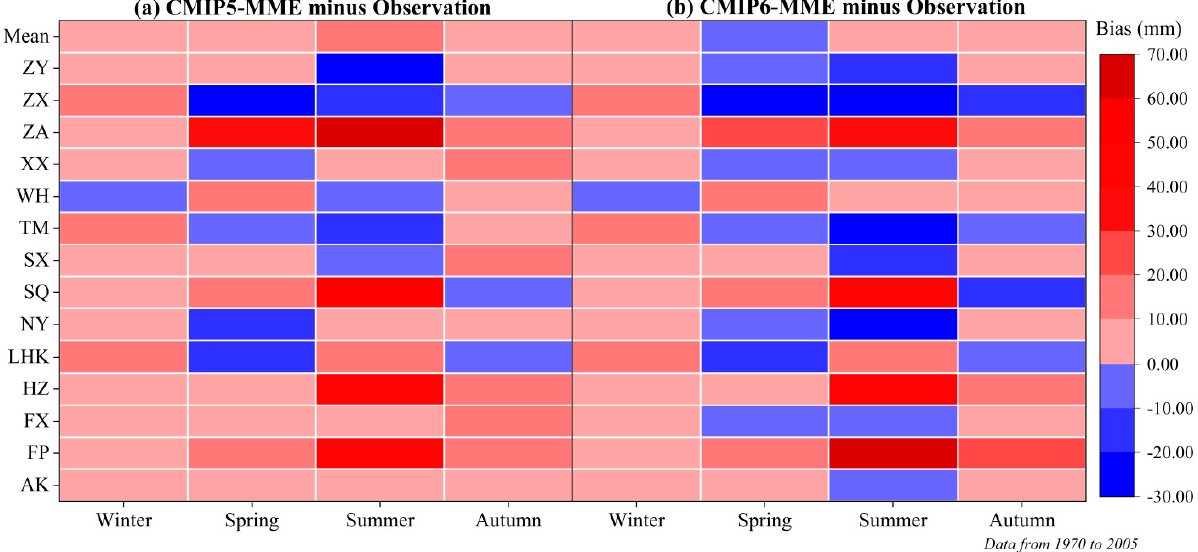
Figure 11. Precipitation biases (GCM minus observation) ( a ) between CMIP5-MME downscaled data and observed data, and ( b ) between CMIP6-MME downscaled data and observed data in winter, spring, summer, and autumn from 1970 to 2005.